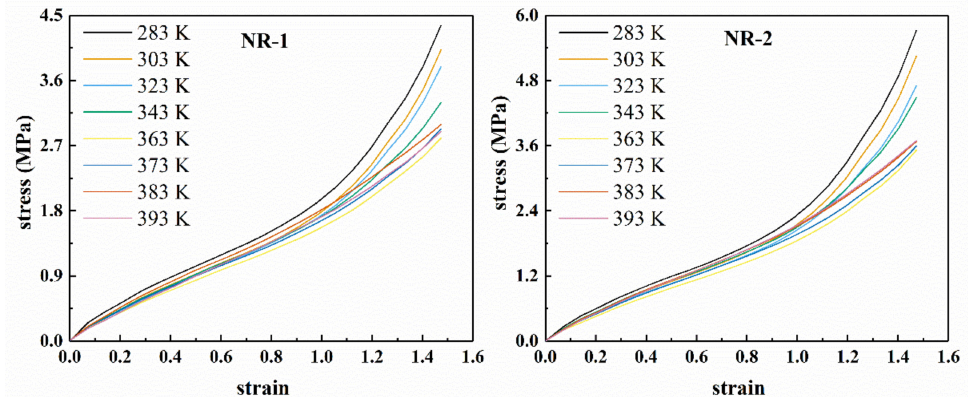
Figure 1. Uniaxial tensile stress–strain curves of rubber compounds NR-1 and NR-2 at different temperatures.